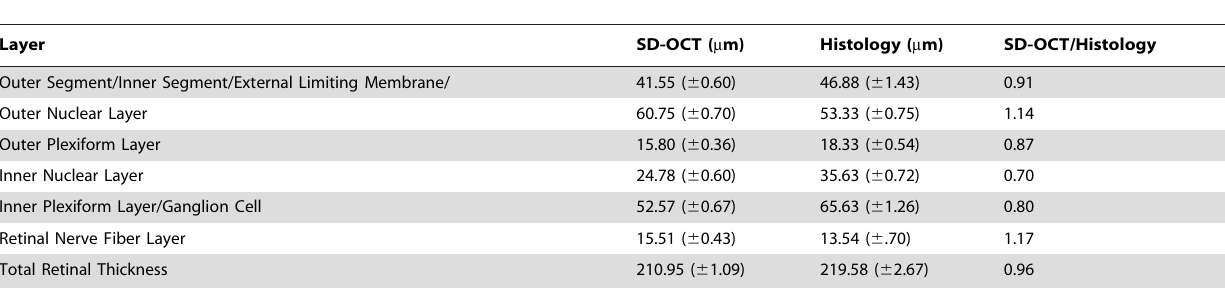
Table 2. Mean ( 6 SE) SD-OCT/histology retinal thickness and calculated ‘correlation constant’ for each retinal sublayer.